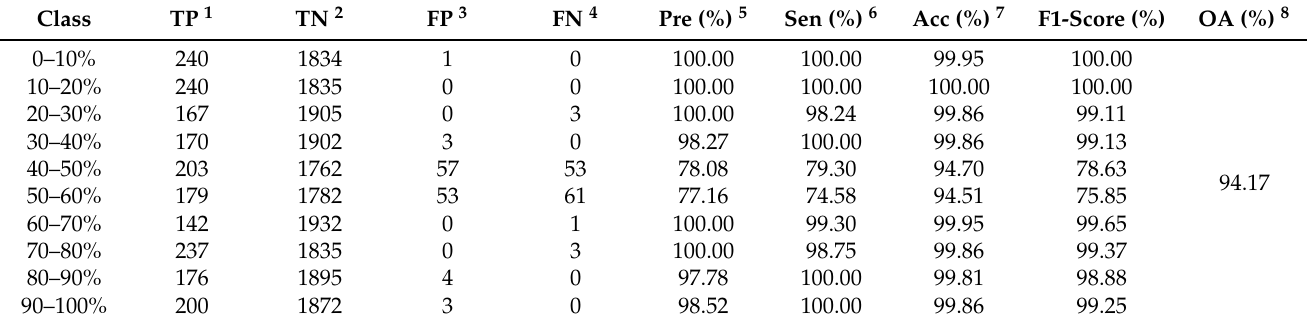
Table 3. Evaluation metrics of EfficientNet–B3–DAN.